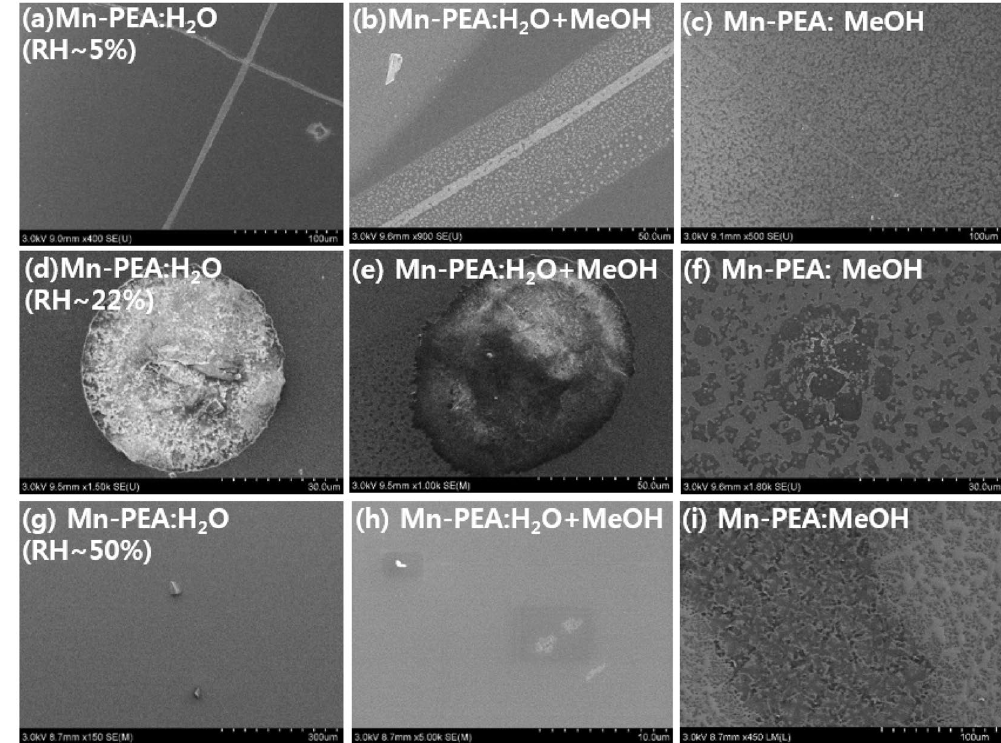
Figure 3. SEM images of three different thin films, that is, Mn-PEA:H 2 O (left), Mn-PEA:MeOH + H 2 O (middle), and Mn-PEA:MeOH (right), depending on RH such as 5% (top), 22% (middle), 50% (bottom). Magnification scale is displayed along with graduated scale at the bottom of each SEM images, which range from 10 μ m to 300 μ